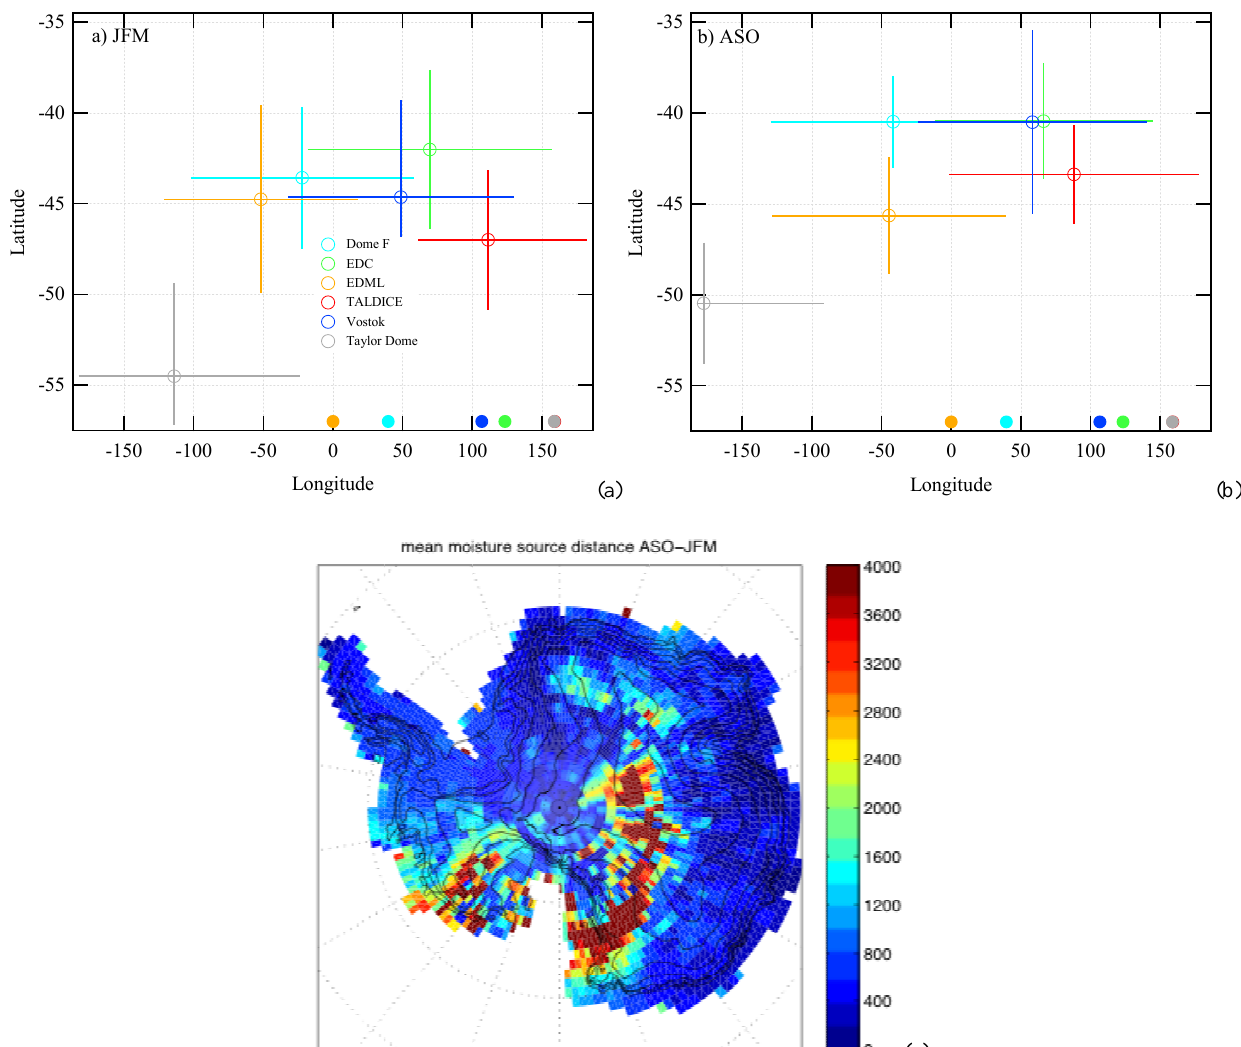
Figure 2ab. Moisture origin calculated from ECMWF analysis data using a Lagrangian moisture source diagnostic and extracted for two three month periods linked with maximum and minimum Antarctic sea ice cover (a, JF, January ‐ February ‐ March, and b, JJA, August ‐ September ‐ October), for the six deep drilling locations studied here (Dome F, EDC, EDML, TD, TALDICE and Vostok). The longitude of each drilling site is displayed with a filled circle on the horizontal axis (the grey and red circles for TD and TALDICE are overlapping each other). The mean moisture source latitude and longitude is displayed with an open circle. Error bars depict the standard deviation of the source latitude and longitude calculated (precipitation ‐ weighted) from the monthly mean values (themselves based on 6 ‐ hourly trajectories), for each season, for the grid points within a 100 km radius around each ice core site.